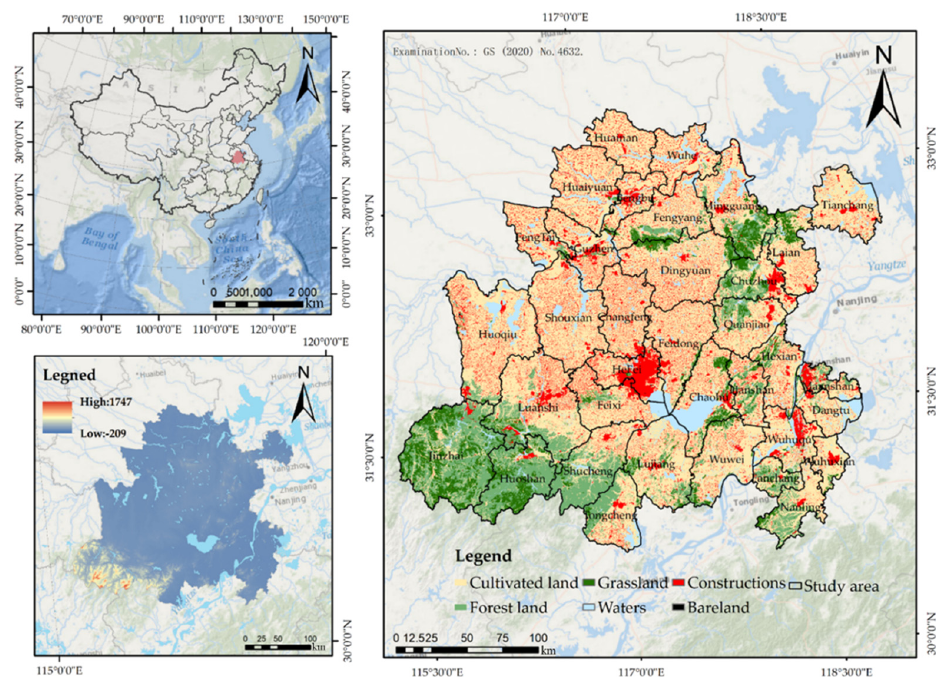
Figure 1. Topography and land-use types in the study area.